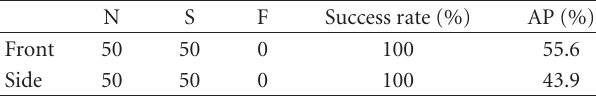
Table 10: The experiment results of goal score